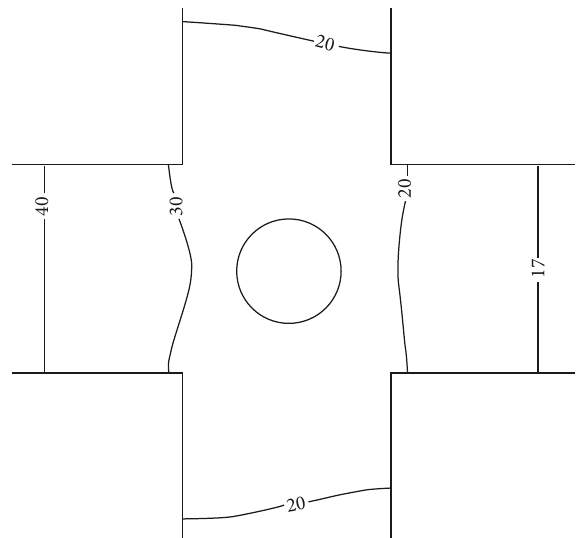
Figure 4: Voltage diagram in the cross channel.